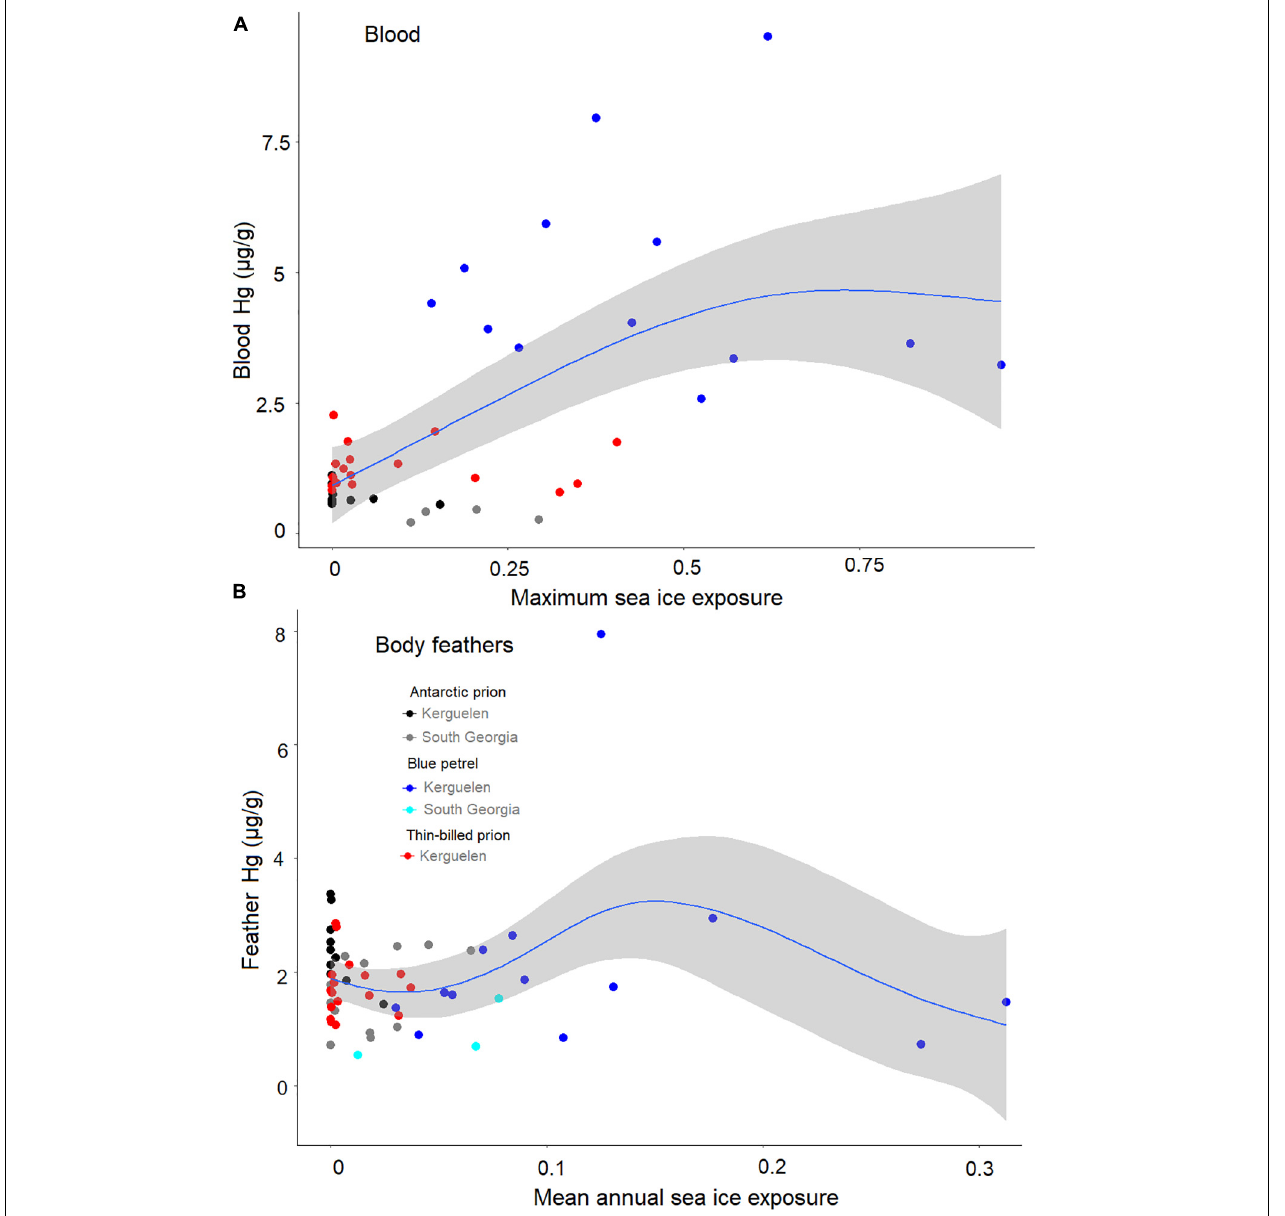
FIGURE 11 | Mercury concentrations in relation to the year-round sea-ice exposure of tracked Blue Petrels, Thin-billed Prions, and Antarctic Prions, shown for blood samples (A) and body feathers (B) . Grey shaded areas show GAM smoothed 95% confidence intervals, obtained in the R package “ggplot2”, across the whole